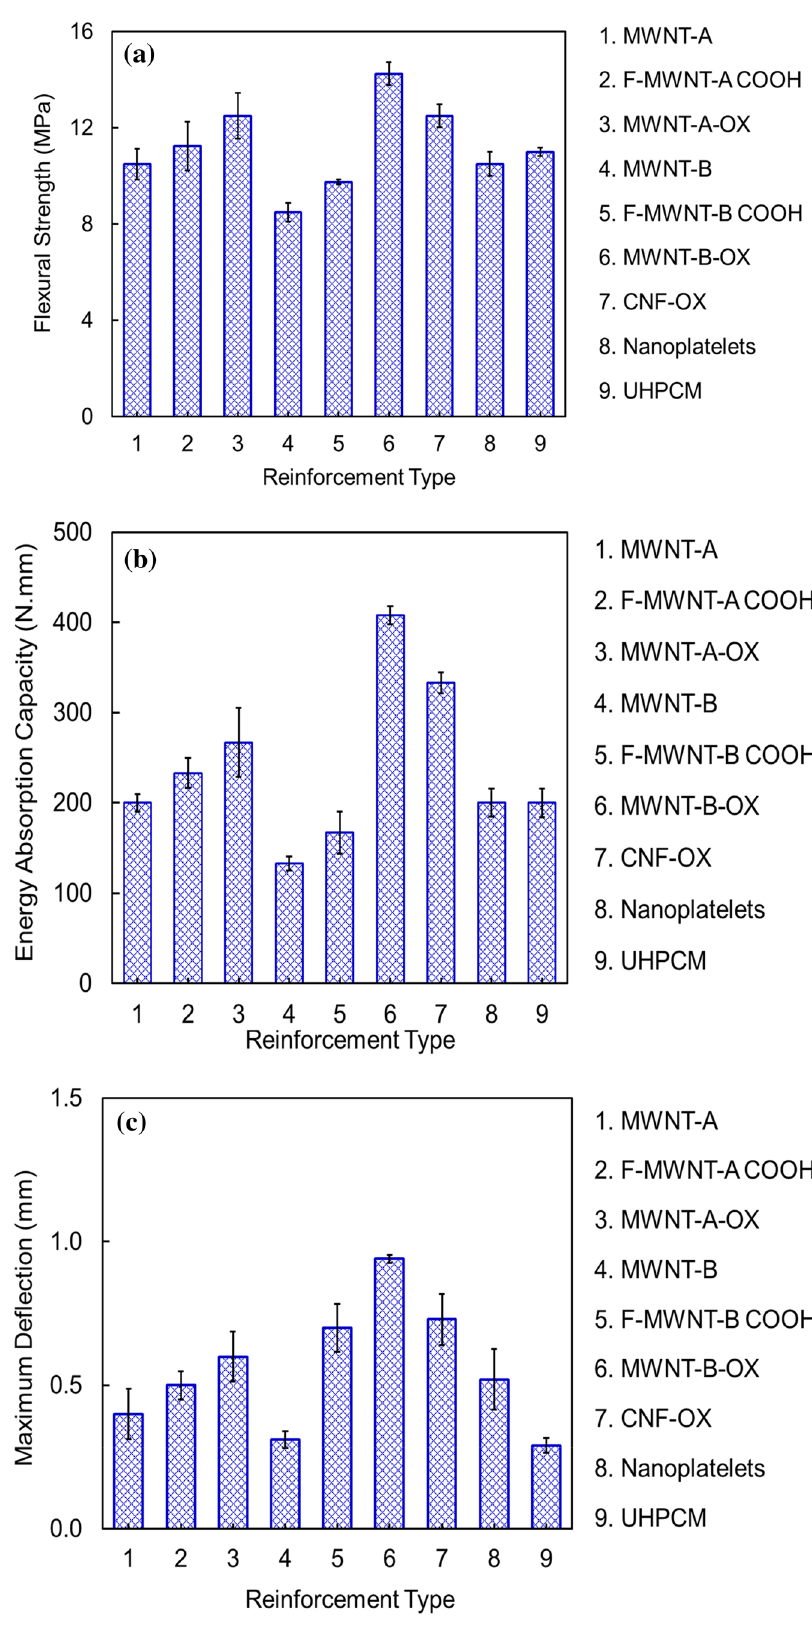
Fig. 6 Flexural performance for UHPCM reinforced with CBNs at 0.03 wt.%: a. flexural strength; b. energy absorption capacity; and c. deflection. Error bars shown are standard deviations determined from 6 replicate